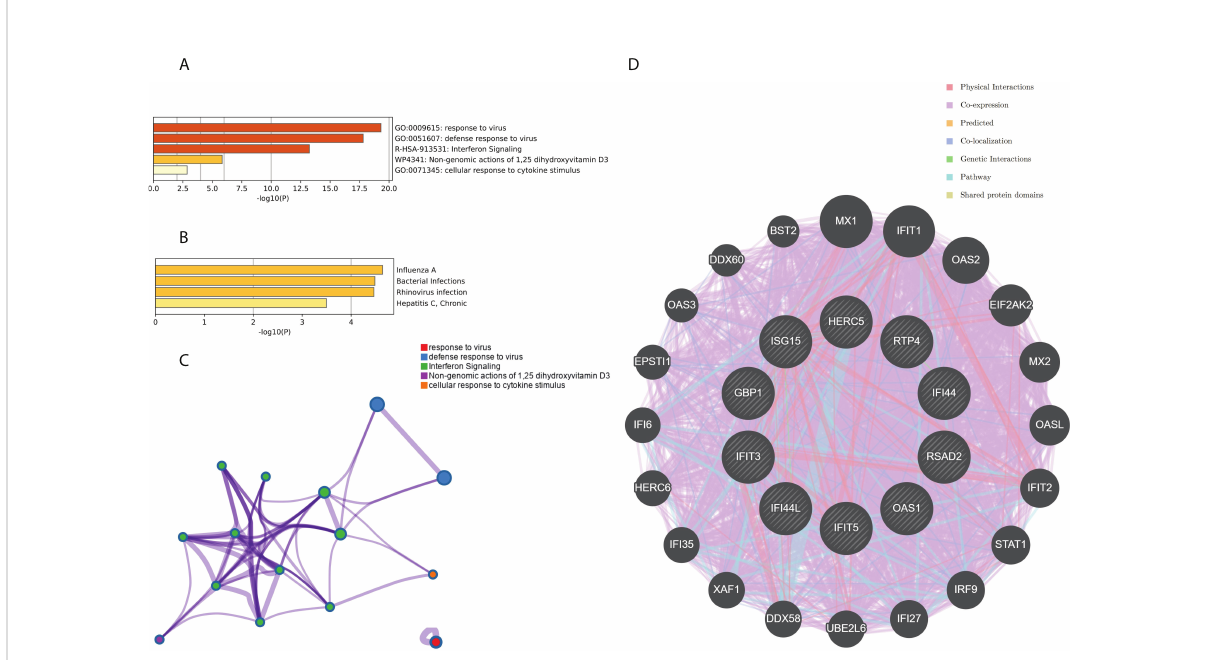
FIGURE 7 Functional enrichment analysis: Metascape and GeneMANIA of top 10 hub genes. (A) Pathway and process richness analysis of the Metascape platform. (B) Summary of enrichment analysis of DisGeNET 13 on Metascape platform. (C) The network is visualized using Cytoscape 5 , colored by cluster IDs, and nodes sharing the same cluster ID are usually close to each other. (D) The gene – gene interaction network of the top 10 hub genes with the 20 most adjacent genes was analyzed using the GeneMANIA database. Each node represents a gene. The color of the linkage of the nodes represents the linkage between the corresponding